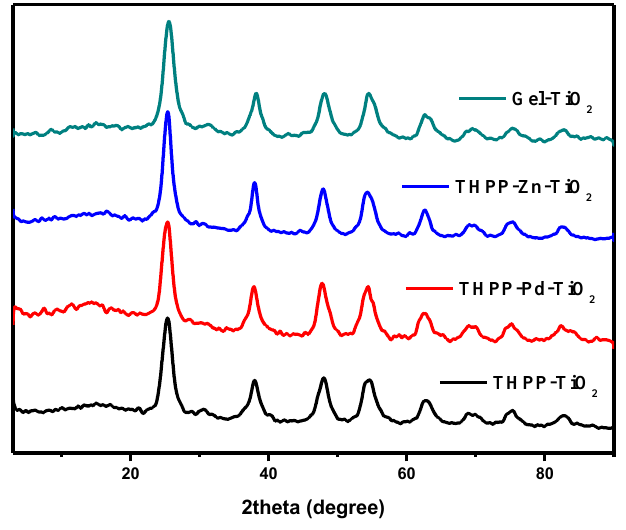
Figure 1. The XRD patterns of Gel-TiO 2 , THPP-TiO 2 , THPP-Pd-TiO 2 and THPP-Zn-TiO 2 .